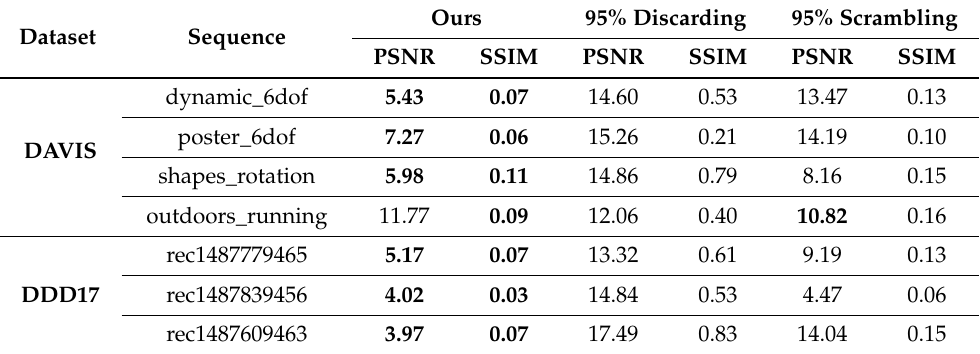
Table 1. The PSNR and SSIM results of the comparison between the original reconstructed images and the reconstructed images after using different encryption algorithms.